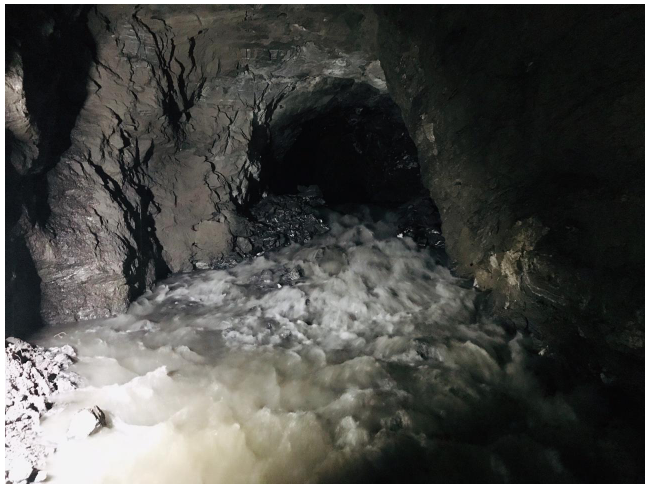
Figure 5. A photo of heavy ingress of water in the tunnel of